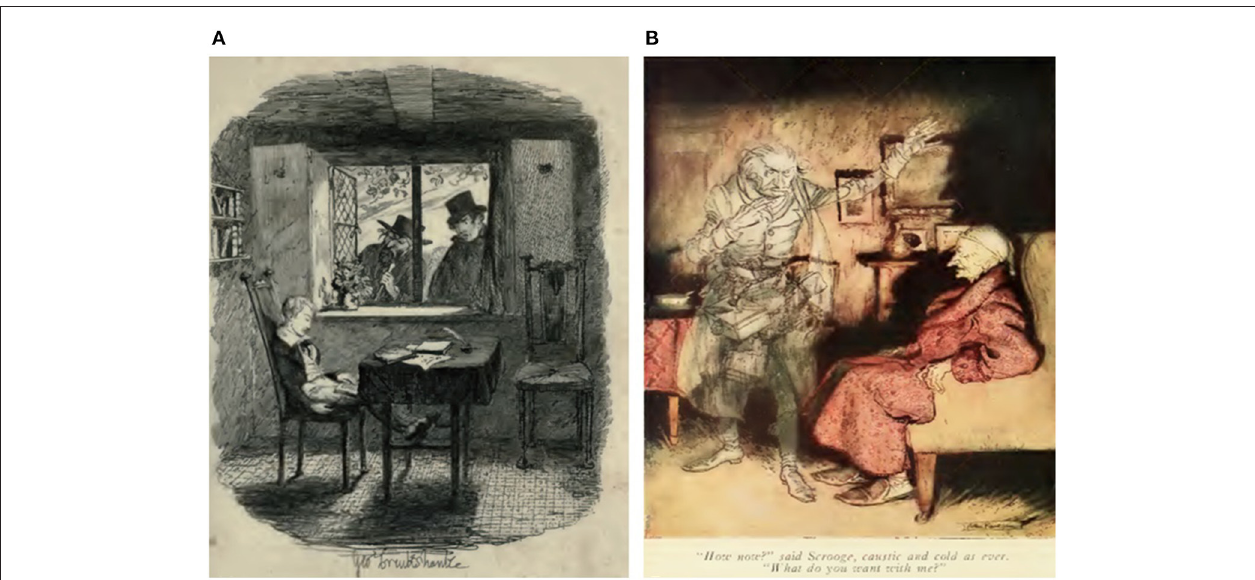
FIGURE 2 | The dreamlike mental state experienced in two Dickens’ characters. (A) . Oliver saw Fagin and Monks through the windows ( Oliver Twist , v.2, p. 261). (B) . Ebenezer Scrooge is visited by the ghost of his former business partner Jacob Marley ( A Christmas Carol ). Drawings: public